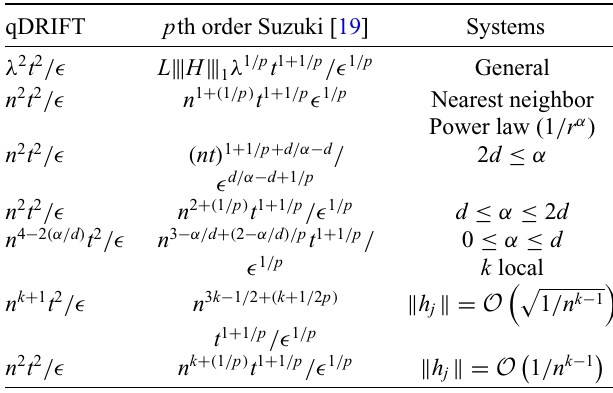
TABLE I. Error-bound comparison Q DRIFT versus pth order Suzuki formulas [19]. We consider systems with spatially local interaction in d dimension, power-law interaction in d dimen- sion, and all-to-all k -local interaction. Mutiplicative overhead depending only on p , k , α , d , log ( n ) are dropped, and practically we may think of p = 4 or 6. The t 2 -dependence sets a time scale before which Q DRIFT yields an advantage. For geometrically local Hamiltonians, the Suzuki formulas are effectively tight [ 21] [Exploiting locality, Ref. [21] further removes the o ( 1 ) depen- dence], while Q DRIFT already performs poorly after very short times [ t ∼ O ( 1 / n ) ]. However, once L gets very large, such as in k -local models, there are physically relevant time scales t = O [ n ( k − 3 )/ 2 ] where Q DRIFT becomes advantageous. Note that normalization conventions do affect the gate count substantially. For systems with random coefficients (e.g., SYK-like), one typ- (cid:3) (cid:3) (cid:2) (cid:3) (cid:3) 2 = ically fixes n [27,29]. But other conventions, like h j (cid:3) (cid:3) (cid:2) j (cid:3) (cid:3) = fixing λ = h j n , are also widespread [30]. We refer to j Appendix A for detailed